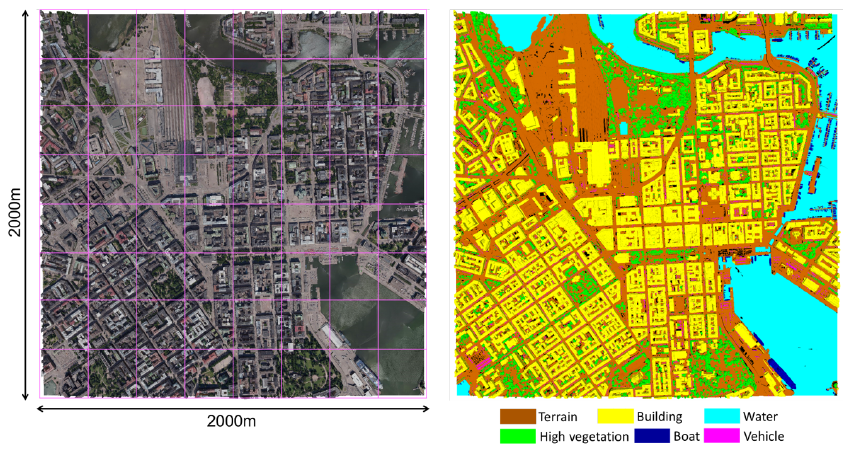
Figure 3. SUM dataset (Gao et al., 2021).